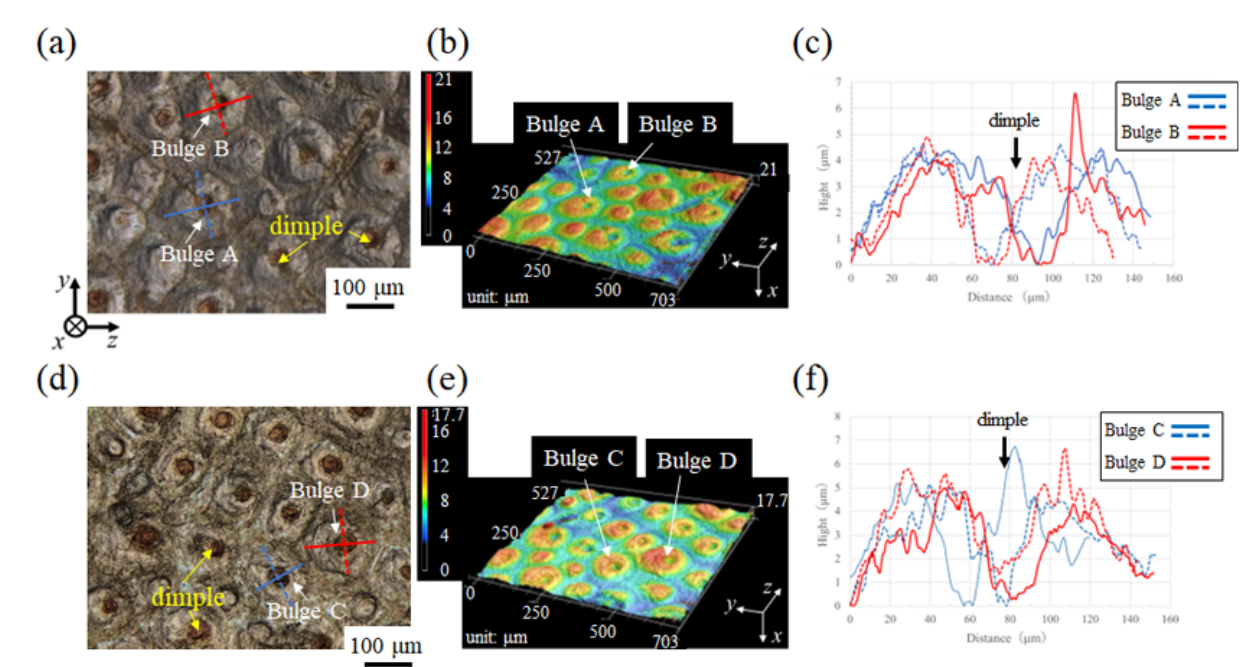
Figure 5. ( a ) Laser scanning microscope image of the surface of the mottled, deep-blue samples placed in air for 3 months after thawing, ( b ) 3D color map showing bulges on the surface, and ( c ) line profiles in two orthogonal directions on two bulges, A and B in ( a ). ( d ) Laser scanning microscope image of the surface of another sample placed in air for 3 months after thawing, ( e ) 3D color map showing bulges on the surface, and ( f ) line profiles in two orthogonal directions on two bulges, C and D in ( d ).